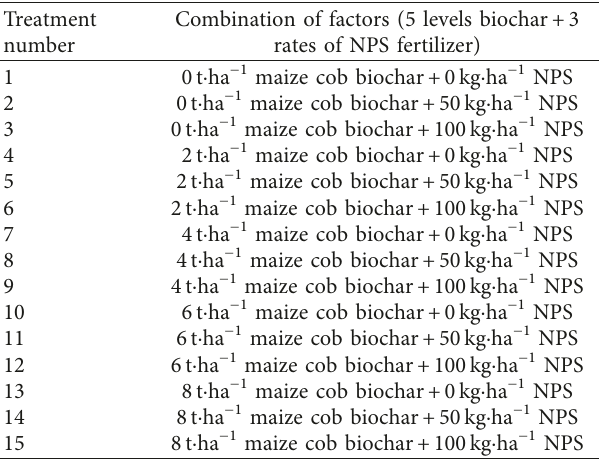
Table 2: Treatment used for the experiment. Treatment